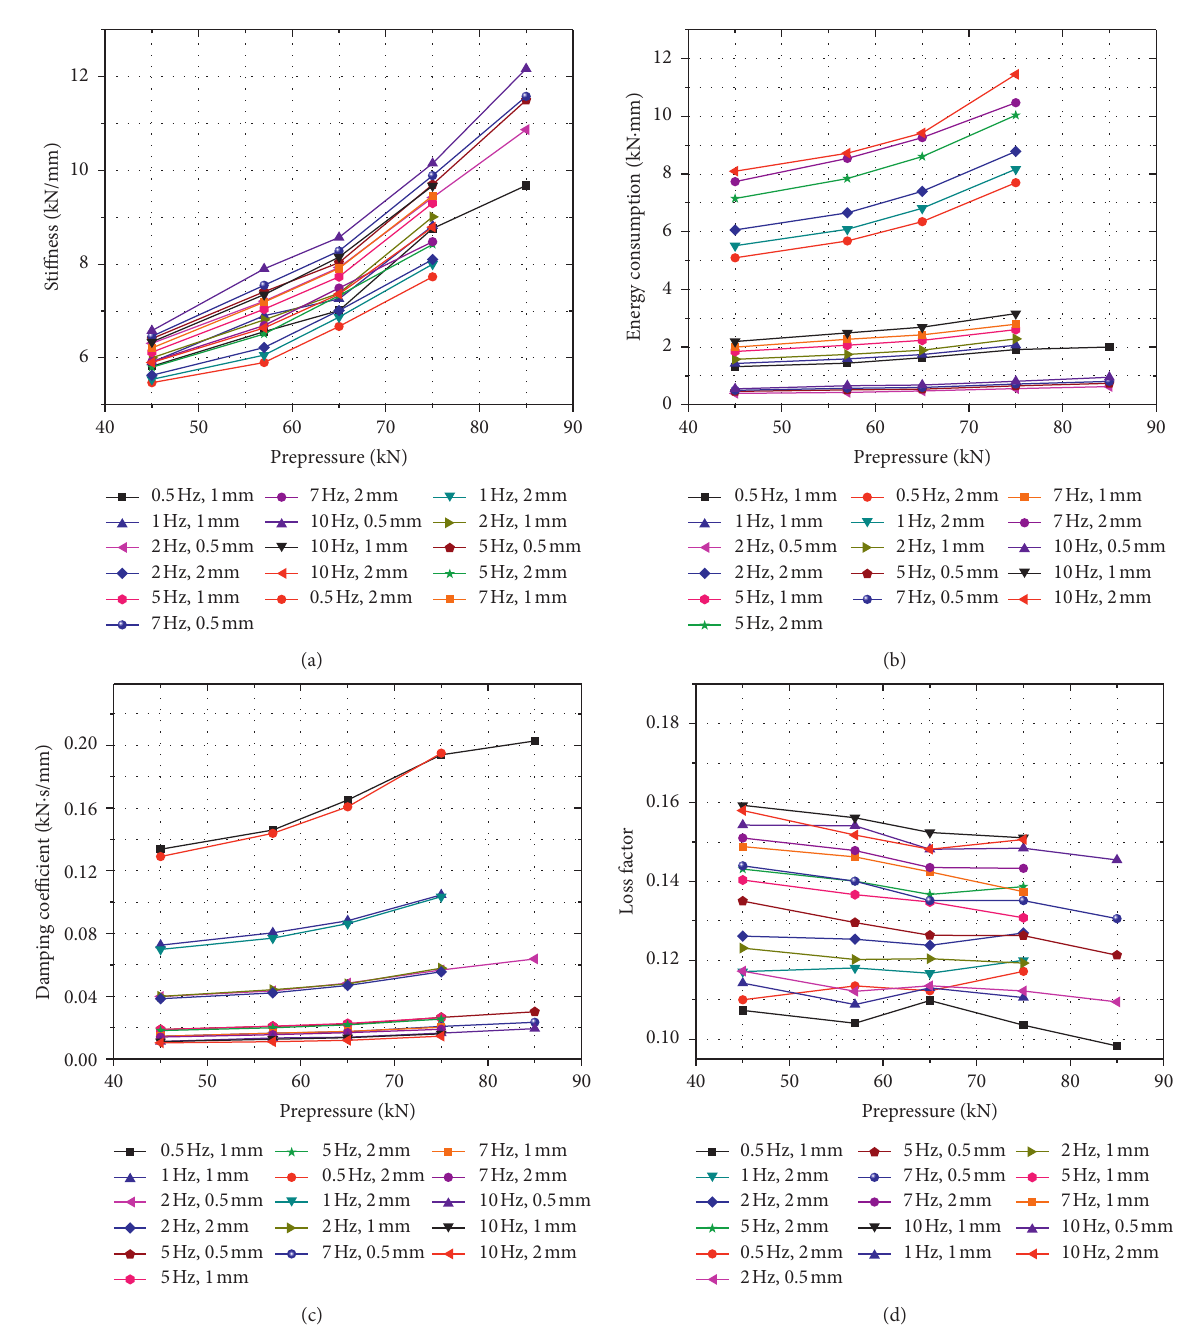
Figure 5: The change curve of dynamic parameters with